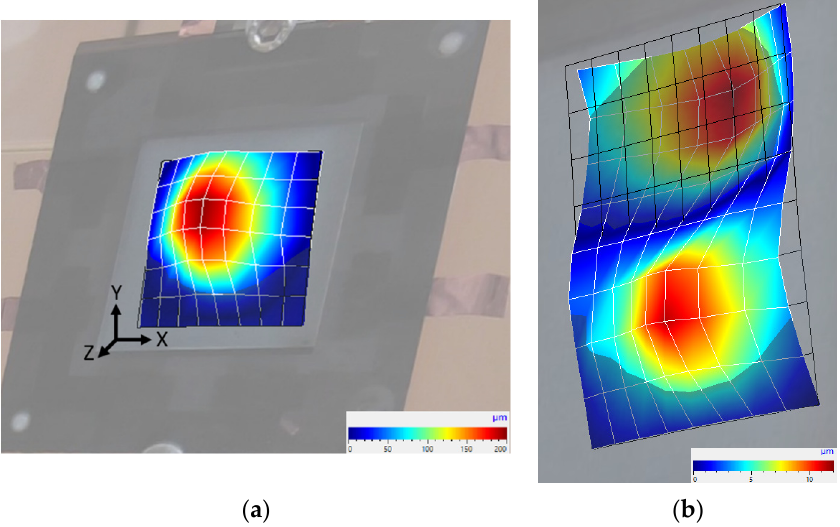
Figure 5. Deflection shape of the multilayer sample at: ( a ) 320 Hz (resonance frequency) and; ( b ) 640 Hz (second harmonic) at 50 V rms . All five P(VDF-TrFE) layers are parallel connected and activated.